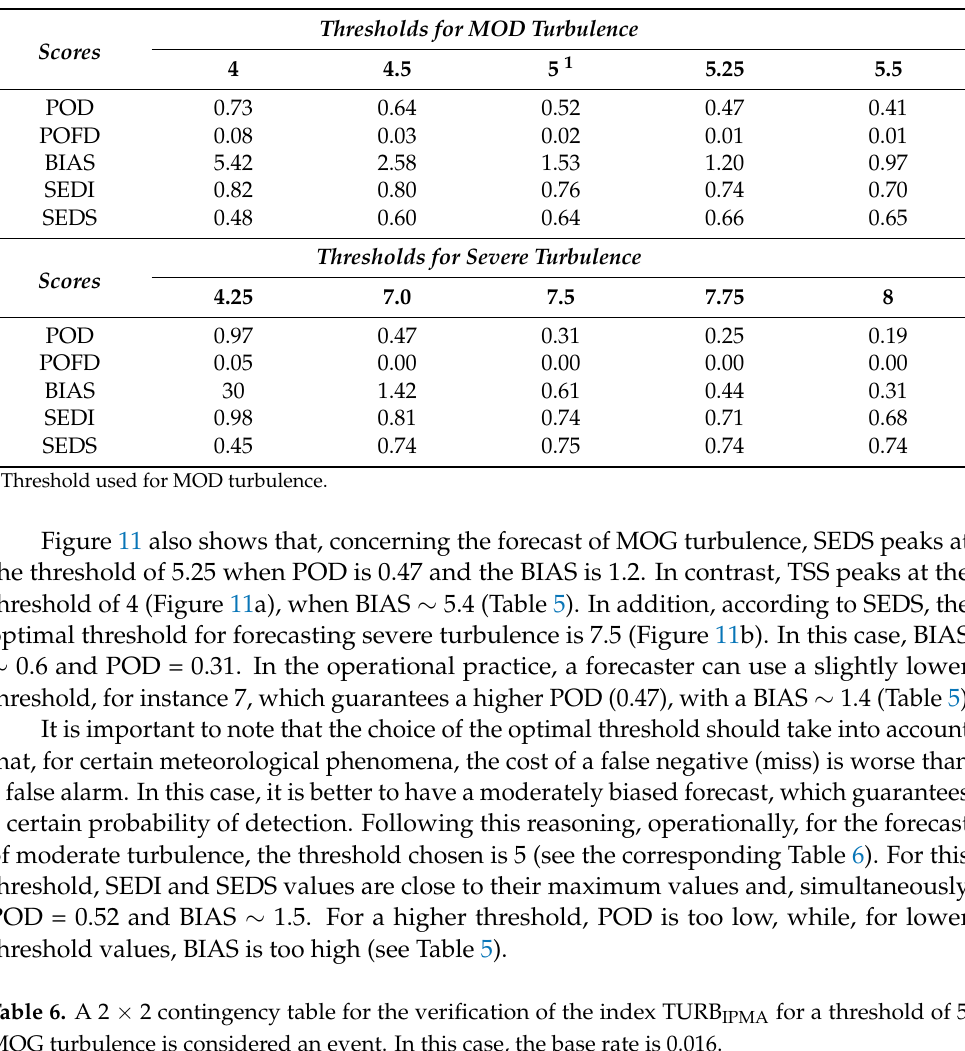
Table 5. Scores of TURB IPMA concerning the forecast of MOD and SEV turbulence.